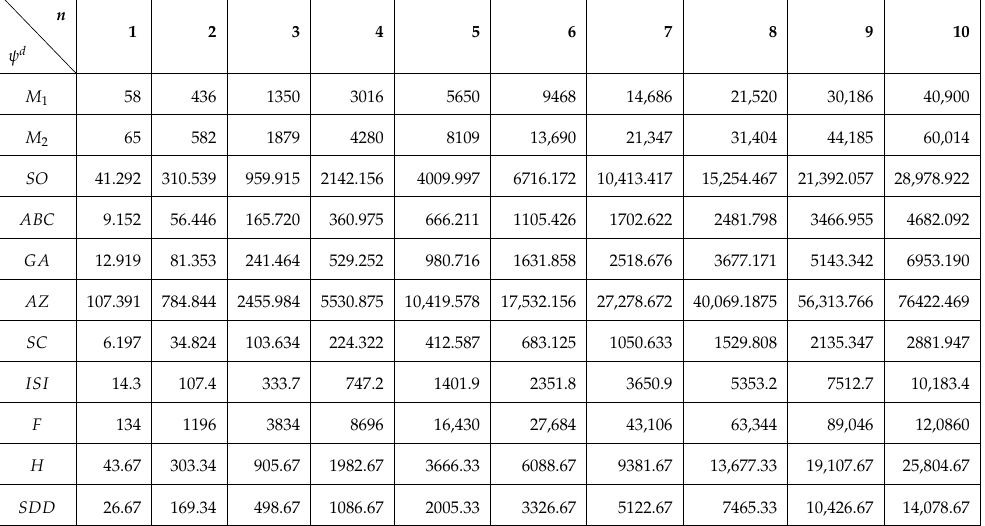
Table 6. Degree descriptors of wave-like nanoribbons WNR ( n , n , n )